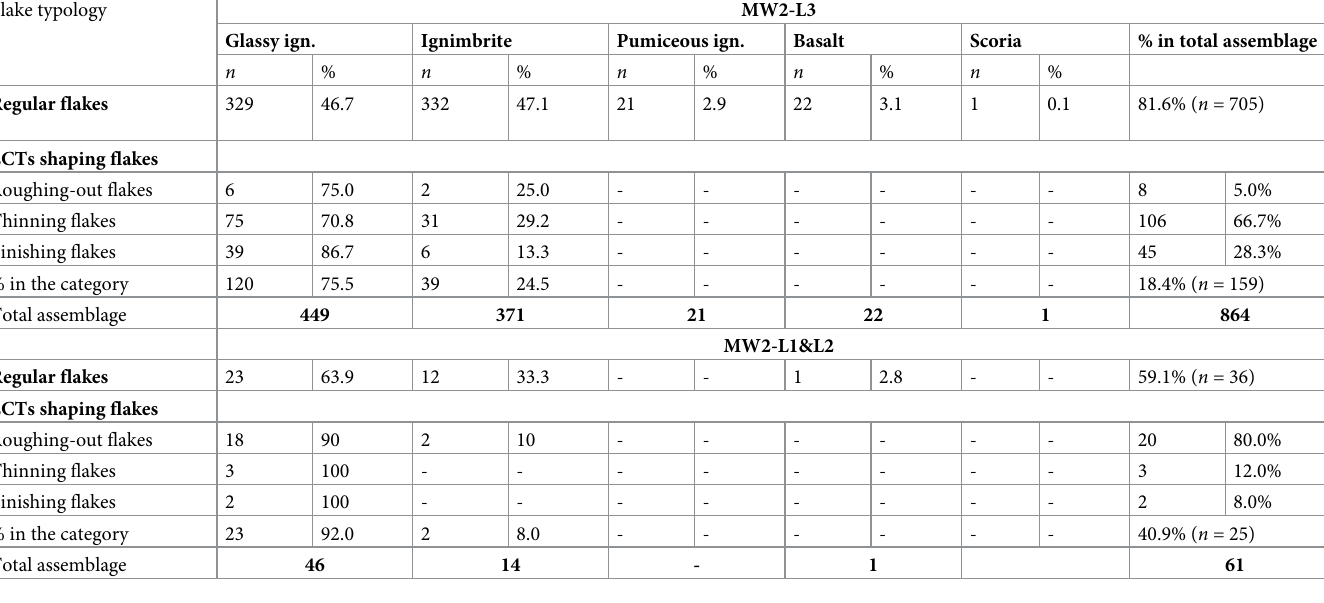
Table 6. Breakdown of numbers of small to medium-sized flakes in MW2 assemblages broken down to raw material categories. Flake typology